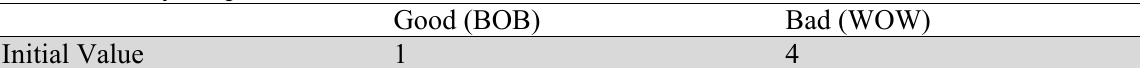
Initial Assembly Response